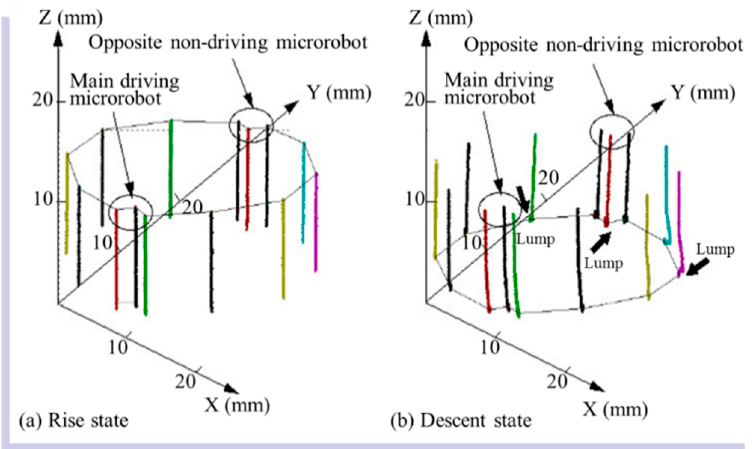
Figure 23. Path of the marks on the microrobots during vertical ( a ) climbing and ( b ) descending by the connected microrobots. The path spread at the points indicated by the thick arrows in ( b ) because the microrobots were being driven even after reaching the base plate, and the wheels slipped on the base plate, causing the microrobots to vibrate.